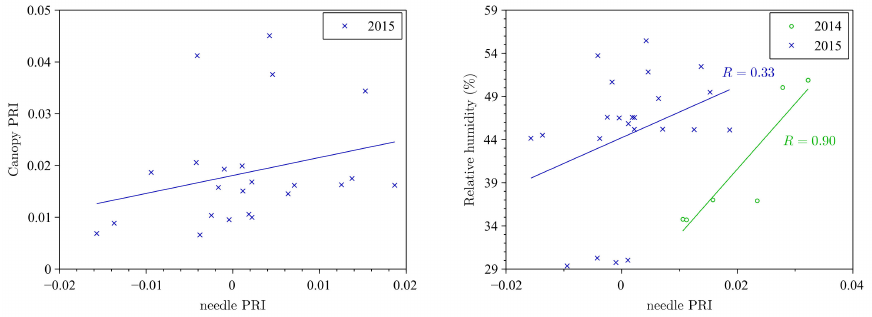
Figure 6. Correlations between sunlit needle PRI and ( a ) canopy PRI, and ( b ) relative humidity. All measurements made at high light levels (PPFD > 1000 µ mol m − 2 s − 1 ). Canopy PRI data were only available in 2015.